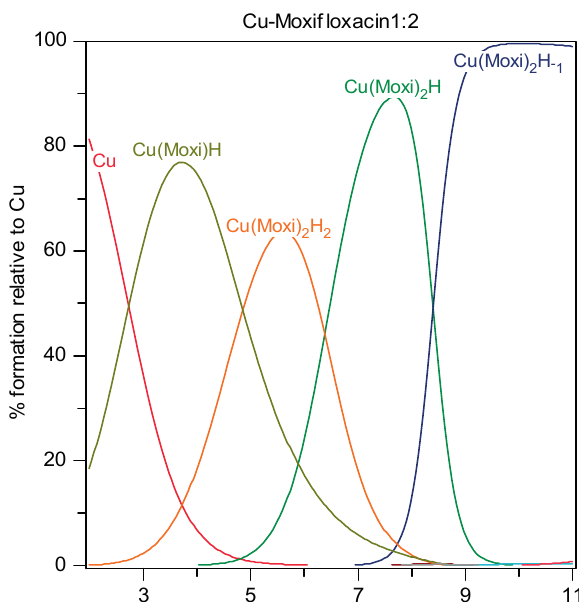
Figure 4. Distribution diagram of Ni-moxifloxacin species at ligand-to-metal concentration ratio 2:1 and total metal concentration 1.0 mmol/L.